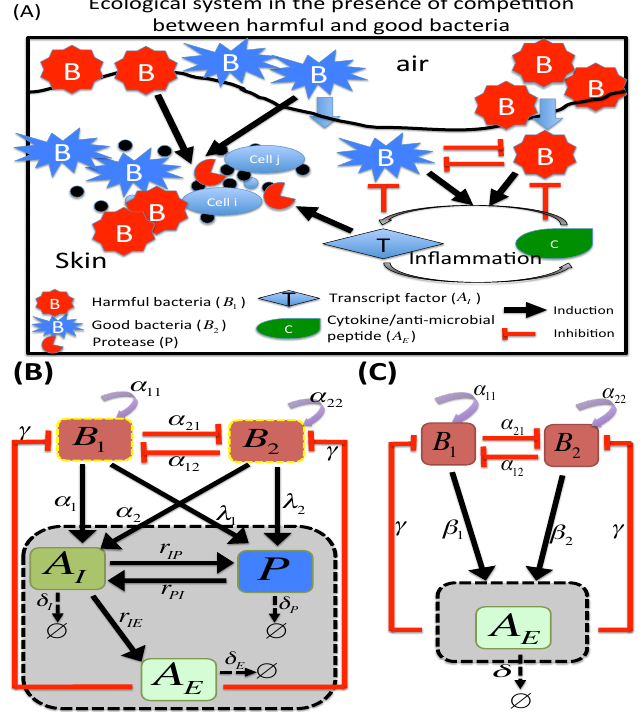
Figure 2. A schematic of the M2 model. ( A ) A schematic of the biological system for the competition between harmful and good bacteria and immune responses. There exists mutual antagonism between harmful and good bacteria. On the other hand, bacterial infection induces upregulation of the transcriptional factor (blue diamond) within the cell for immune activity and secretion of proteases (red quarter pie) for enhanced bacterial invasion. Induced extracellular cytokines (green) from transcription factor (blue) then suppress both harmful (red star) and good (blue star) bacteria. All arrows refer to the induction of gene expression or proteins. The hammerheads from and to bacteria ( B 1 , B 2 ) refer to the inhibition or suppression of bacterial growth. ( B ) Topological networks representing the biological observations in (A). Densities of harmful bacteria, good bacteria, proteases, intracellular transcription factor and extracellular cytokines are represented by ‘ B 1 ’, ‘ B 2 ’, ‘ P ’, ‘ A I ’ and ‘ A E ’, respectively. ( C ) The final network model that abstracts the key structure of the network in (B). By merging a multi-species compartment (gray box in (B) including ‘ A I ’, ‘ P ’ and ‘ A E ’) into a compartment ‘ A E ’ (gray box in (C)), we get a simpler model in